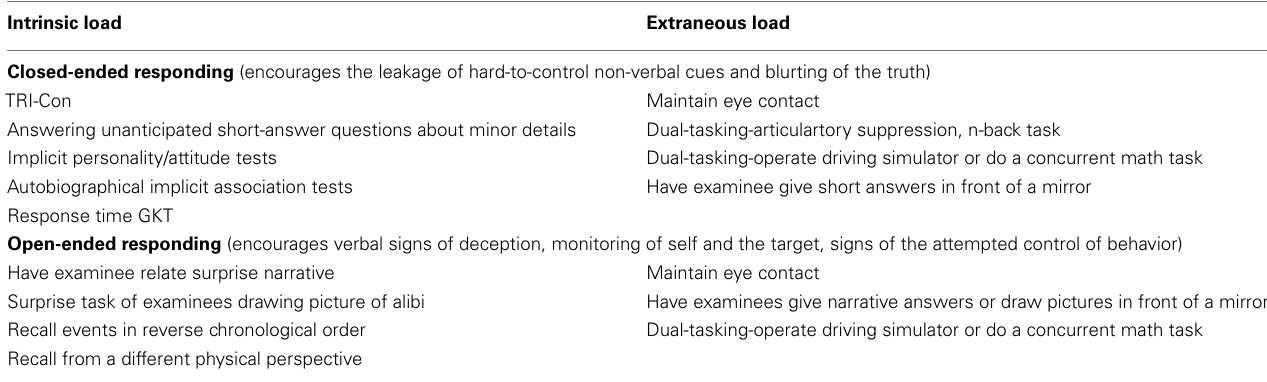
Table 2 |A taxonomy of load-inducing lie detection: the type of cognitive load induced and the response open-endedness permitted. Intrinsic